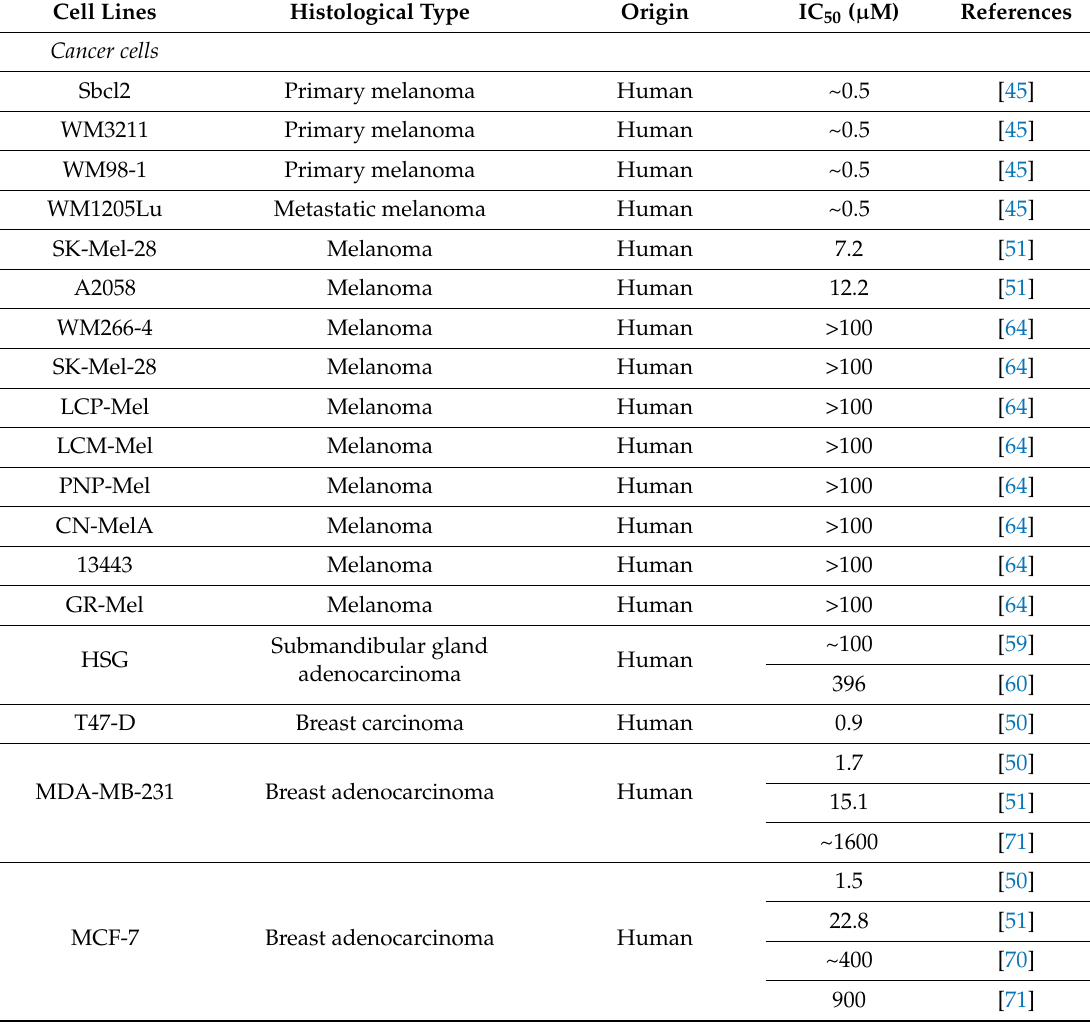
Table 2. Summary of in vitro cytotoxic effects of eugenol against cancer and non-cancer cell lines. Cell